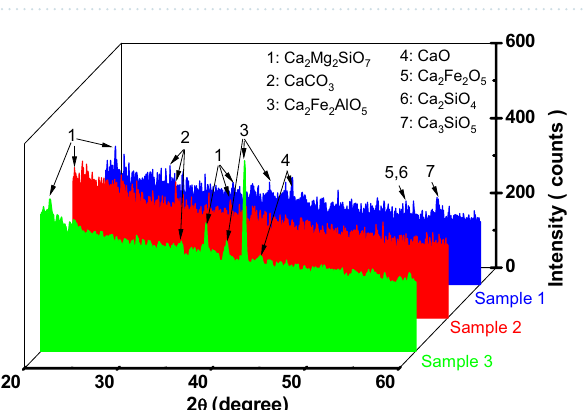
Figure 4. EDX spectra analysis of slag samples.